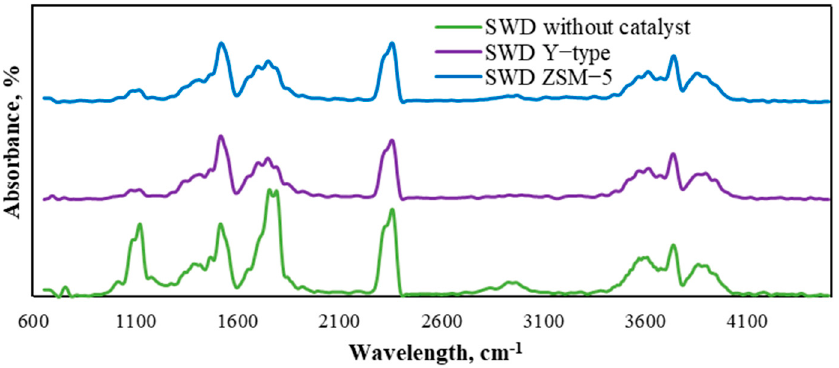
Figure 4. Functional group analysis curves from the TGA-FTIR system.